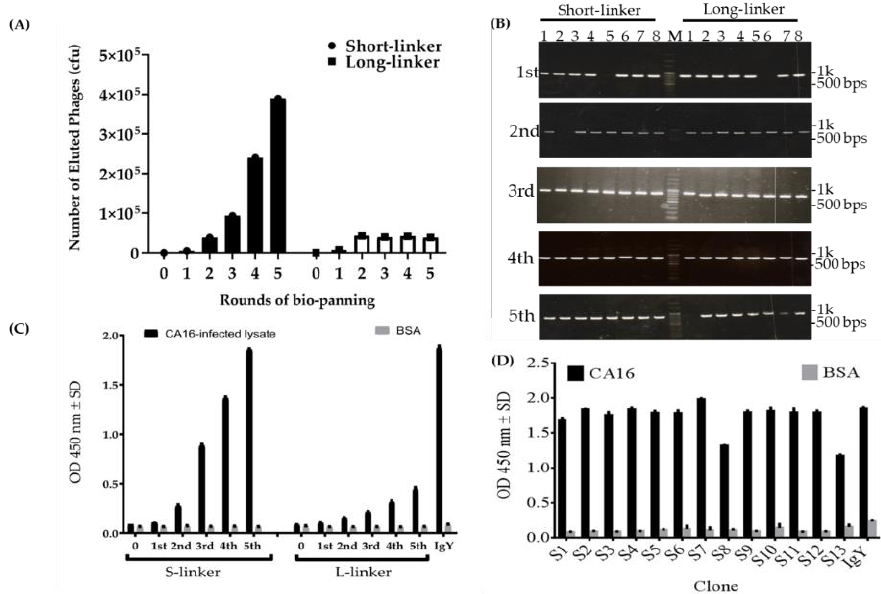
Figure 5. The phage titers, colony-PCR, scFv selection, and their specific binding abilities. ( A ) The recombinant eluted phage titer was checked after the first cycle of panning and throughout the five cycles. Their eluted titer was demonstrated using a colony formation assay. ( B ) After each cycle of the bio-panning process, colonies were randomly selected to confirm the phagemid DNA of the binders; DNA ladder (M) was used for a reference point. ( C ) Amplified phage-binders from each cycle of bio-panning were tested for their binding activities. These eluted titers and their abilities to bind were compared with phages from original libraries (0). ( D ) The ELISA result showed the binding ability of individual clones with short-linkers. IgY-binding protein antibody (1:3000 dilution) was included as a positive control. HRP-conjugated rabbit anti-mouse IgG and HRP-conjugated donkey anti-chicken IgY antibodies were used to confirm the complex at 1:10,000 dilutions, respectively.